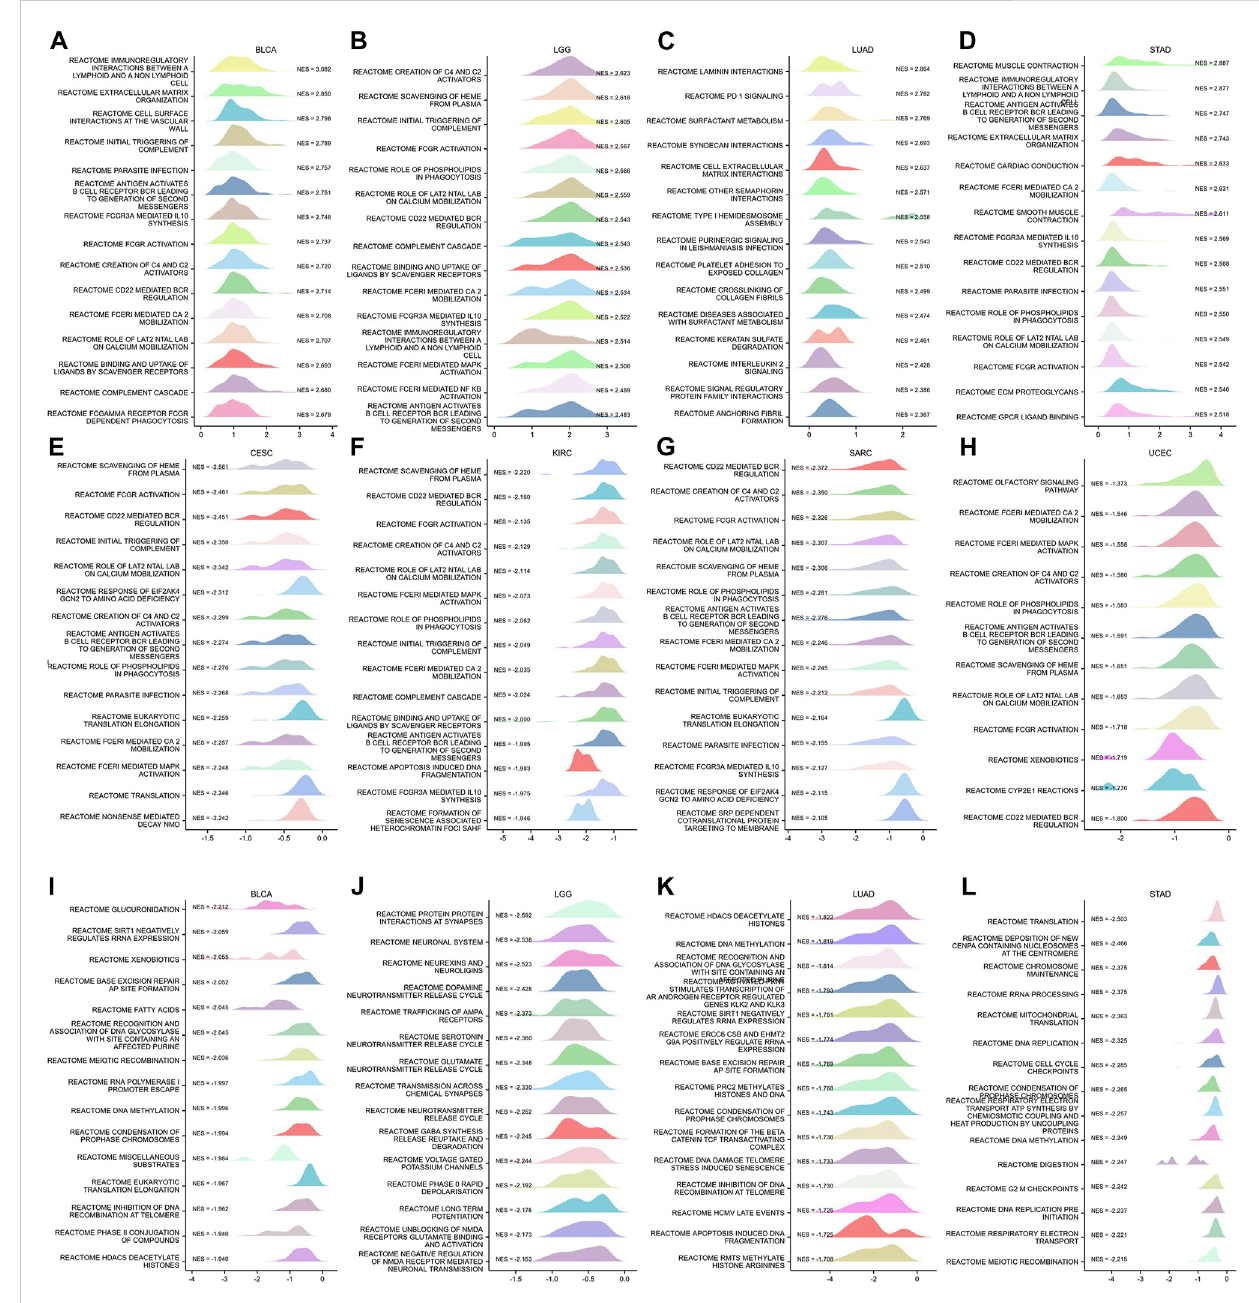
FIGURE 13 GSEAfunctionalenrichmentanalysisofGSNin8cancers.InBLCA (A) ,LGG (B) ,LUAD (C) ,andSTAD (D) ,the fi rst15reactionpathwayswerepositively correlated with GSN expression. In CESC (E) , KIRC (F) , SARC (G) , UCEC (H) , BLCA (I) , LGG (J) , LUAD (K) , and STAD (L) , the fi rst 15 reaction pathways negatively correlated with GSN